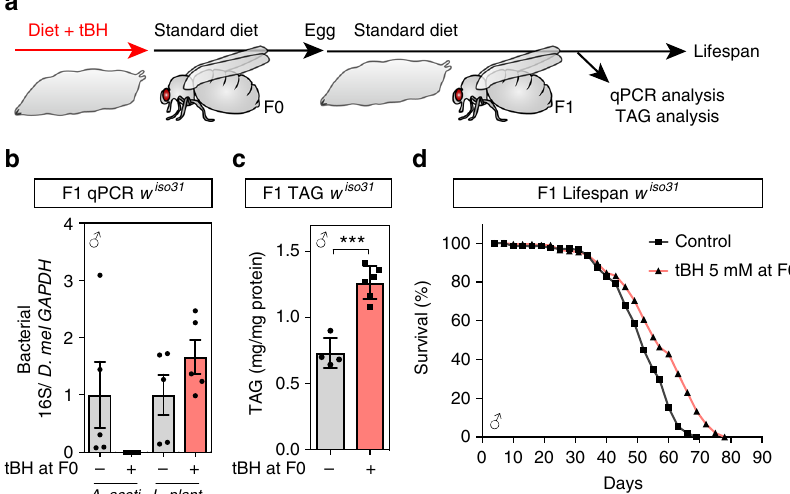
Fig. 5 Transmission of the tBH microbiome, TAG storage and longevity to the next generation. a Outline of experimental strategy. Male and female tBH- experienced fl ies (F0) were mated for 0 – 5 days after eclosion, transferred to a new bottle and eggs collected for 4 h to establish the next generation (F1). b qPCR analysis of bacteria from F1 male fl ies using species-speci fi c primers. Mean ± SEM ( n = 5). c Whole-body TAG (mg/mg protein) in F1 male fl ies. Mean ± SEM ( n = 4 for control and 6 for tBH). d Lifespan of F1 male fl ies. *** p < 0.001. Statistics for survival curves are shown in Supplementary Table